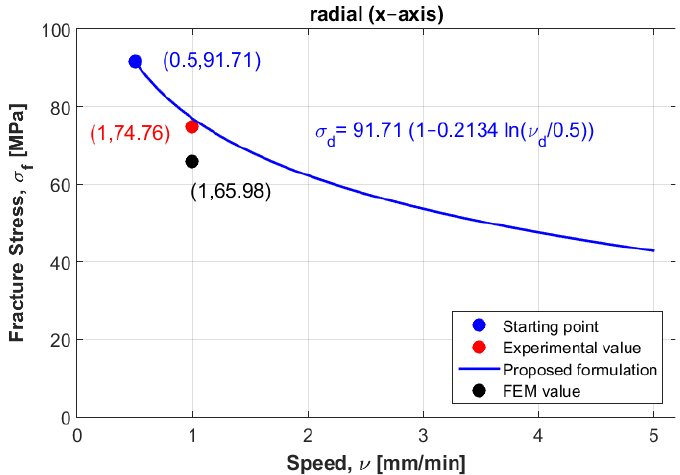
Figure 10. Curve modeling for the radial direction and the experimental point at the second dis- placement rate.